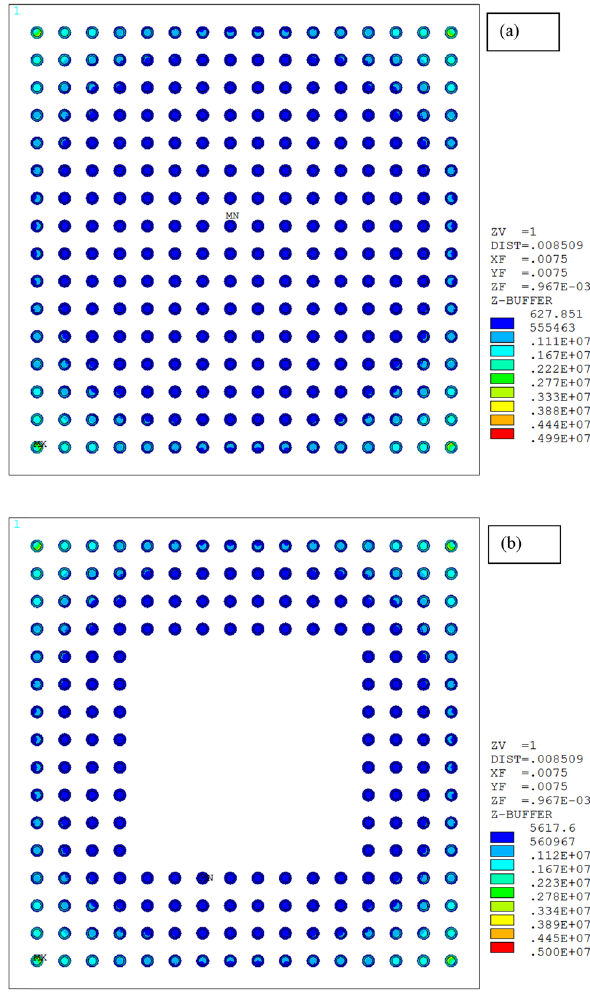
Figure 6: Von Mises stresses of the solder matrix in ( a ) full and ( b ) peripheral layouts.